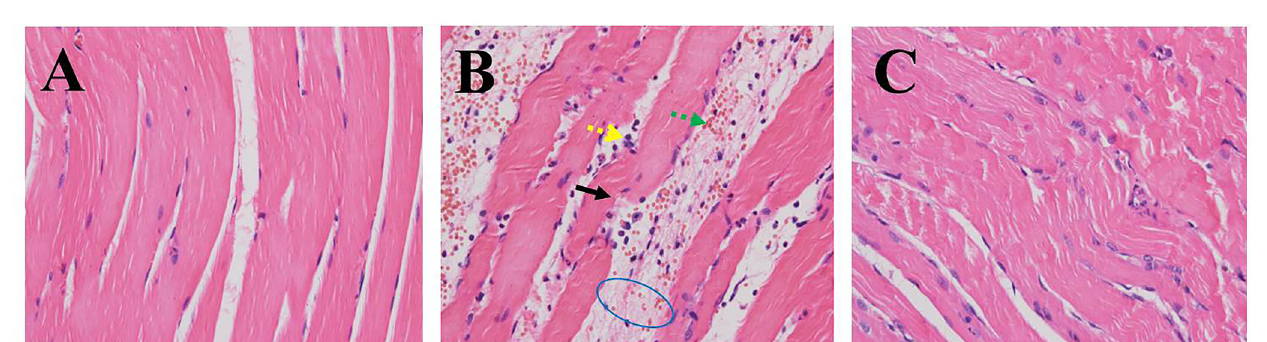
FIGURE 3 - Effect of LS on injured muscle in the TBS rats by HE staining (400 × magnification, black arrow-muscle fiber, yellow arrow-inflammatory cell, green arrow-blood stasis, blue circle-edema). (A) Control group; (B) TBS group; and (C) LS group.